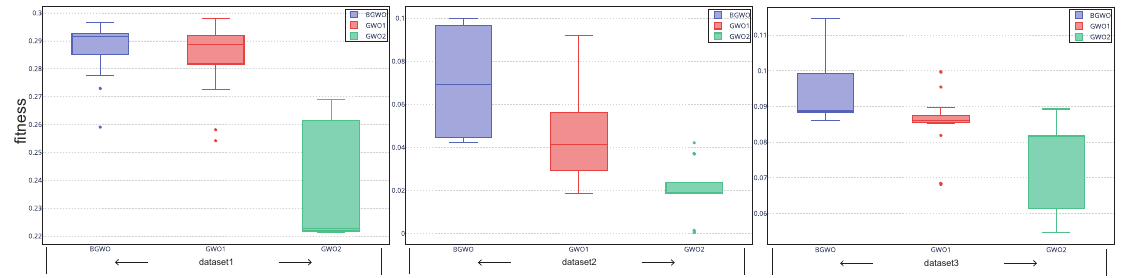
Figure 2. Boxplots for the fitness value obtained from different